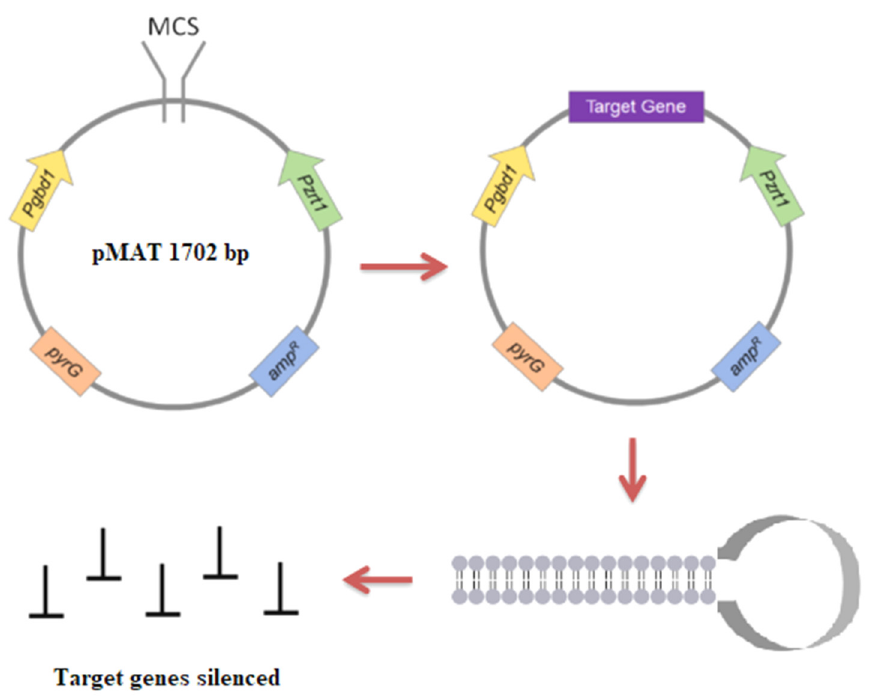
Figure 3. Gene silencing in Mucor and Rhizopus spp. Two convergent promoters flank a multiple cloning site that can be digested, where a target gene can be placed. Amp and pyrG act as selectable markers, and the presence of the carB gene adjacent to the target gene allows for the selection of white colonies post-transformation. The dsRNA resulting from this self-replicative vector can silence the target gene. Data taken from [28].